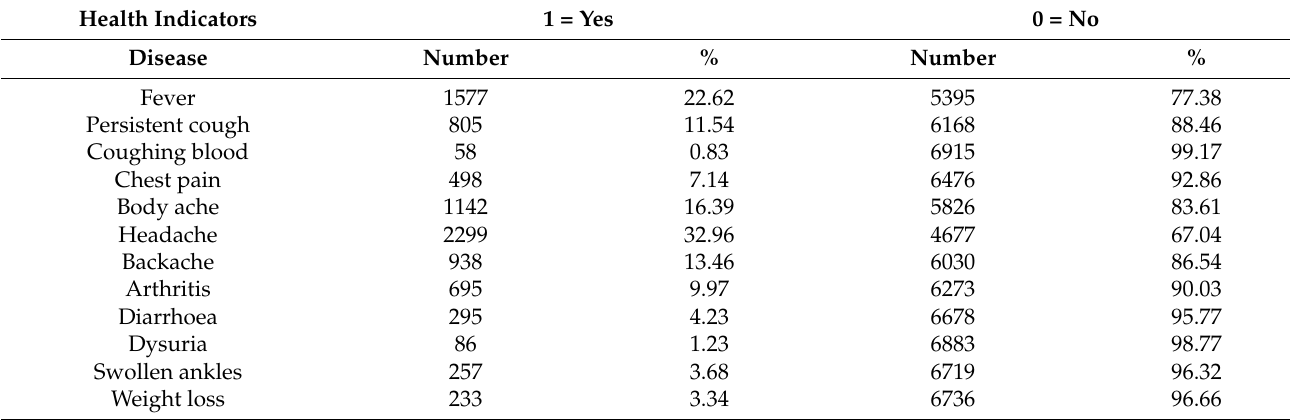
Table 3. Summary statistics for poor health